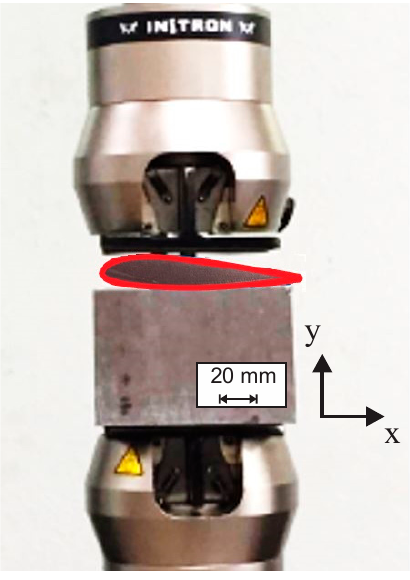
Figure 4. Specimen subjected to compression by the universal testing machine INSTRON 8872.